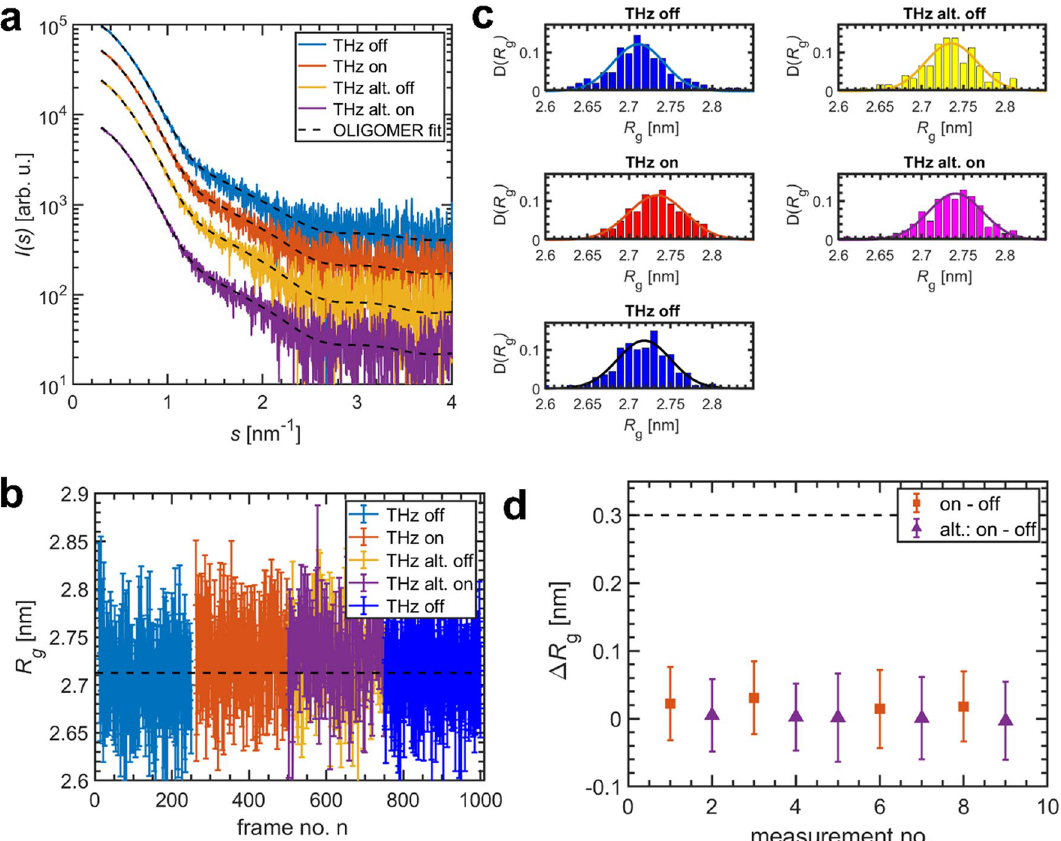
Figure 2. THz-SAXS data for a BSA solution (c = 5.8 mg/mL) at a nominal power density of Φ = 6.5 mW/cm 2 at 0.5 THz (THz source I). a) Single SAXS curves (exposure time: 0.2 s) out of a sequence of 250 frames without (‘THz off’), with (‘THz on’) and for alternating (‘THz alt. off/on’) THz irradiation. Dashed lines: Fits with an oligomeric mixture of BSA monomers and dimers (obtained with OLIGOMER). All curves were shifted along the logarithmic axis for clarity. ( b ) Radius of gyration R g determined for a sequence of SAXS frames under different THz-irradiation. Dashed line: average R g for ‘THz off’ measurements. ( c ) Normalized histograms of the R g -distribution. Solid lines: Gaussian fits. ( d ) Difference of the average radius of gyration ΔR g between THz on- and off -states for several measurements. For alternating radiation, the respective adjacent on/off frames were used. For comparison: Size of the first hydration layer surrounding proteins in solution (dashed